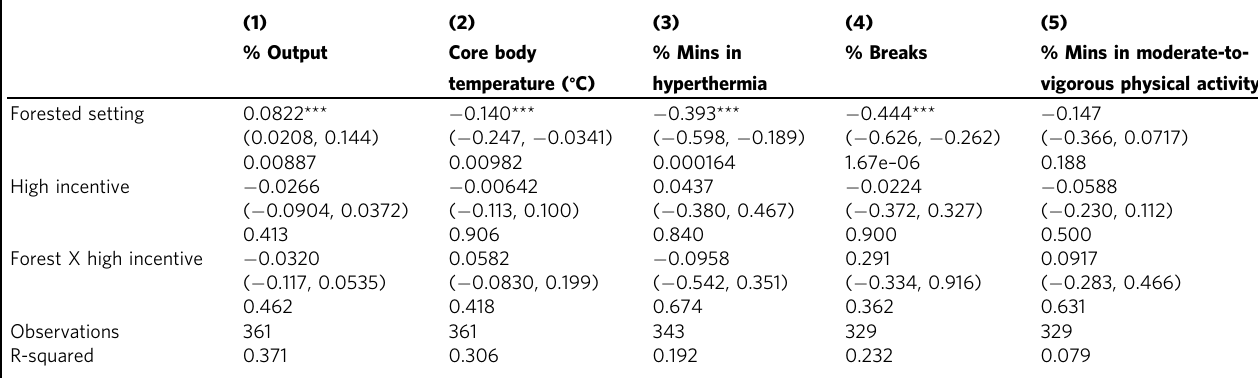
Table 1 Effect of treatment on productivity, core body temperature, hyperthermia, breaks, and physical activity. Below each coef fi cient, we report 95% con fi dence intervals in parenthesis and two-tailed p values, respectively. We denote conventional statistical signi fi cance as *** p < 0.01, ** p < 0.05, * p < 0.1 for two-sided t tests. The dependent variable in Column (1) is the log of total output. In Columns (3), (4), and (5), the dependent variable is the inverse hyperbolic sine of, number of minutes with moderate hyperthermia (with moderate hyperthermia (core body temperature exceeding 38.5 ∘ C), total breaks, and number of minutes spent in moderate-to-vigorous physical activity, respectively. The coef fi cients can be interpreted as semi-elasticities following appropriate econometric transformations 80 . Core body temperatures are estimated from oral temperatures and heart rate data using a validated algorithm 73